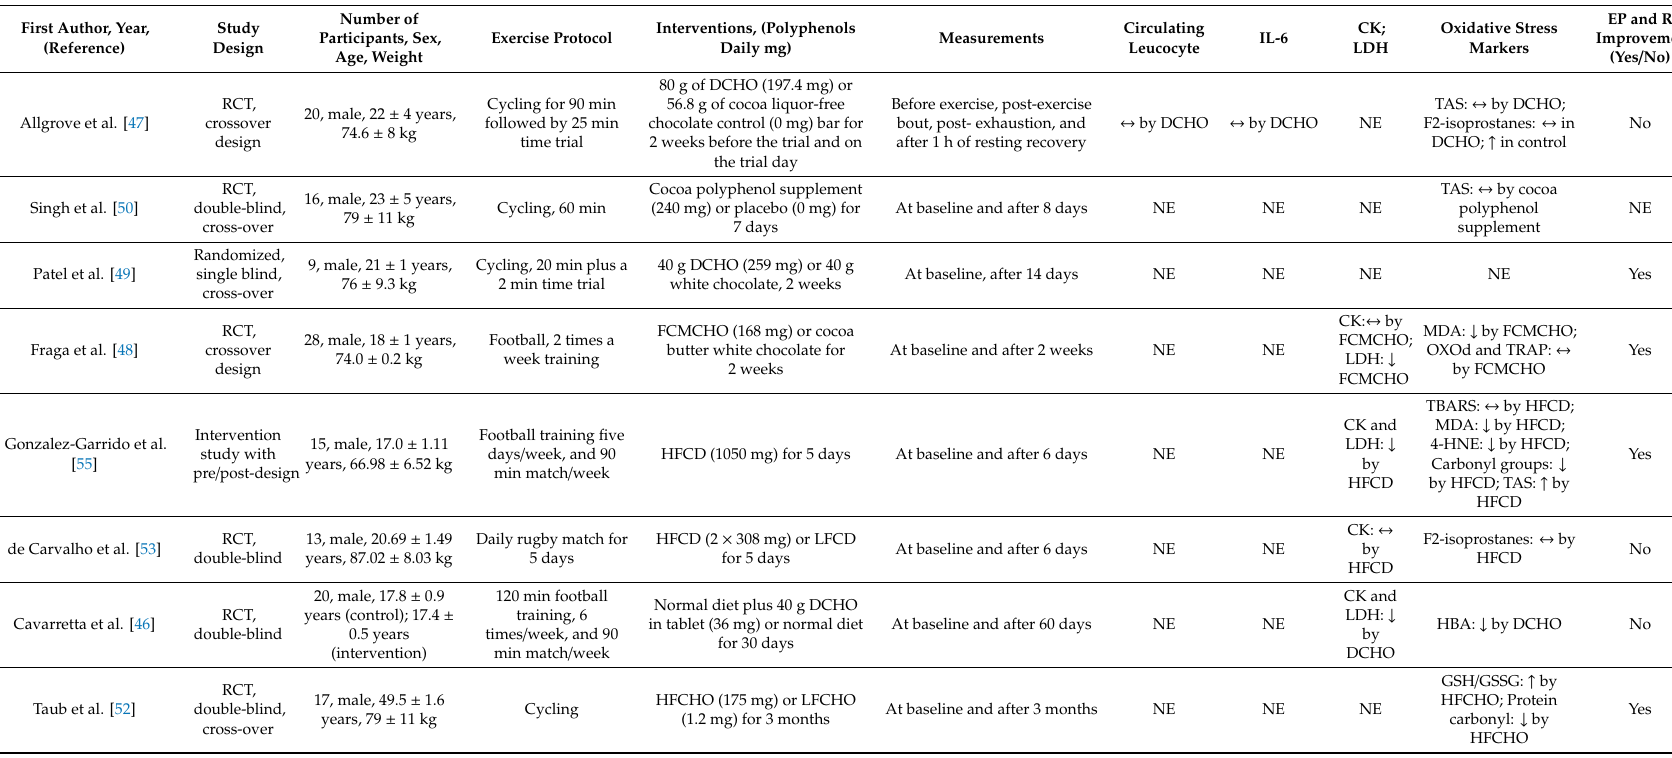
Table 2. Sub-chronic and chronic e ff ects of cocoa polyphenols on exercise-mediated oxidative stress, inflammation, and exercise